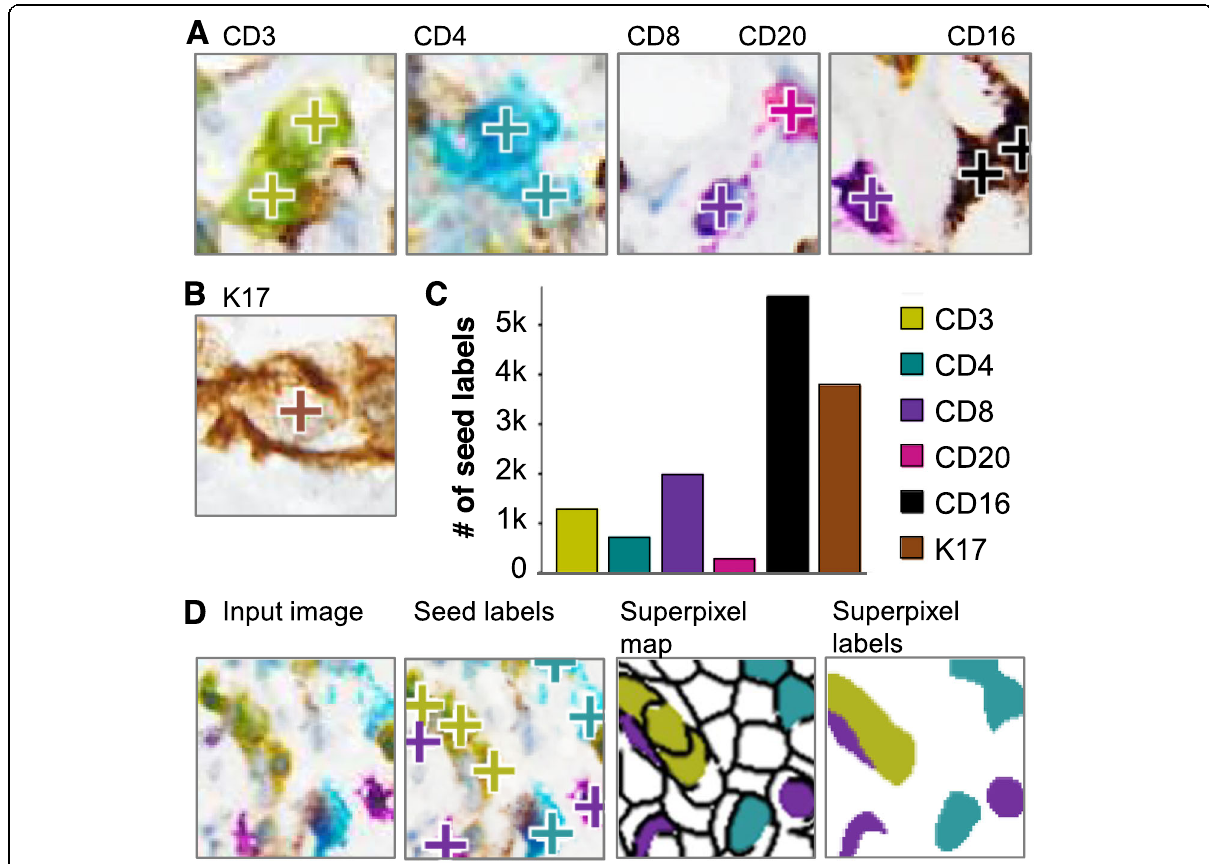
Fig. 2 Annotation of patches with seed labels and generation of per-pixel training data. A . Examples of CD3+, CD4+, CD8+ and CD20+ lymphocytes, CD16+ myeloid cells and B . K17+ PDAC tumor cells with seed labels overlaid (+). C . Number of seed labels for each cell class, across all patches used for training. D . Input image; input image with seed labels overlaid; superpixel map generated based on the input image with superpixels containing different seed labels colored accordingly; and the superpixel labels used to train the models (based on seed labels and superpixel